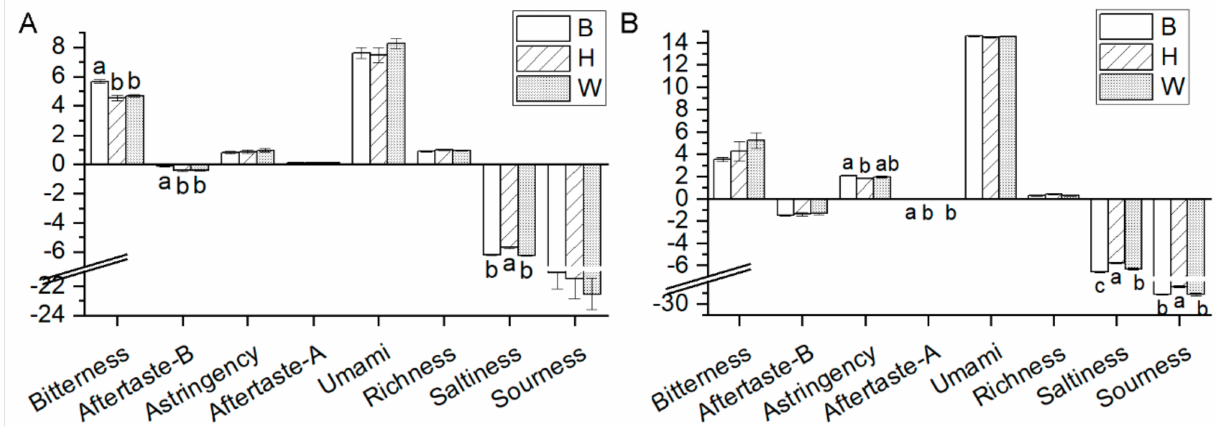
Figure 4. Electronic tongue histograms of egg yolks and albumen from three breeds. ( A ) Electronic tongue histogram of yolks. ( B ) Electronic tongue histogram of albumen. B, Beinong No.2; H, Hy-Line Brown; W, Wuhei. a,b,c means a sensor with no common letters significantly differs ( p < 0.05) ( n =